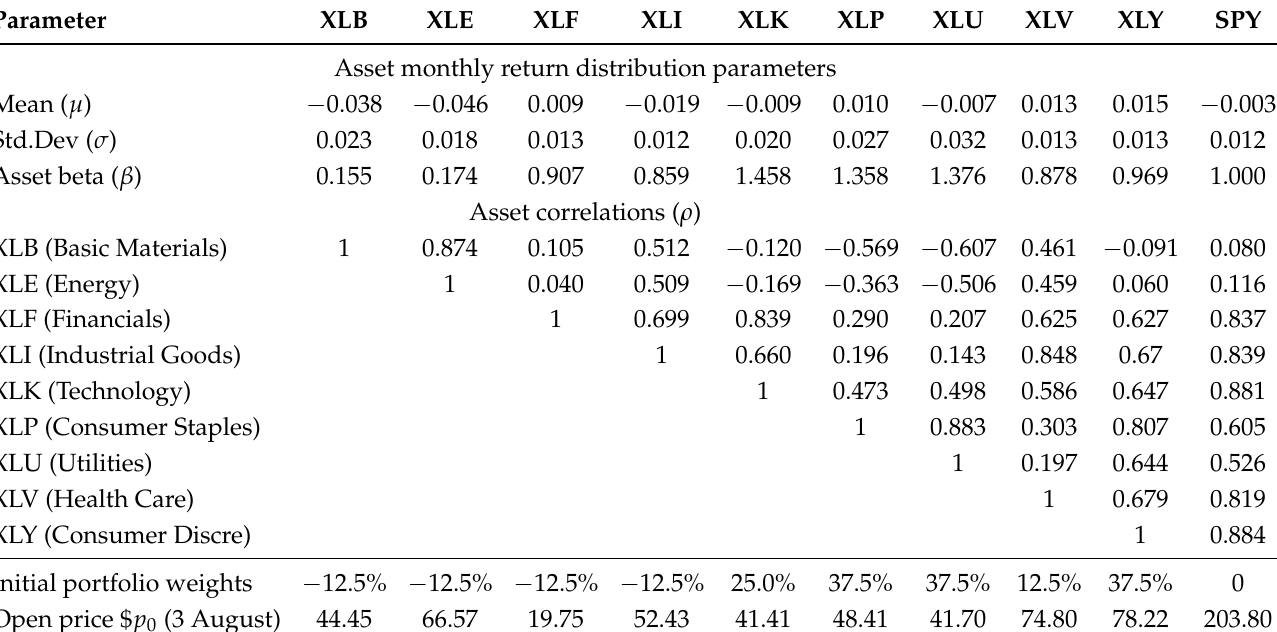
Table 2. Market impact parameters and asset return parameter forecasts for period 3–31 August